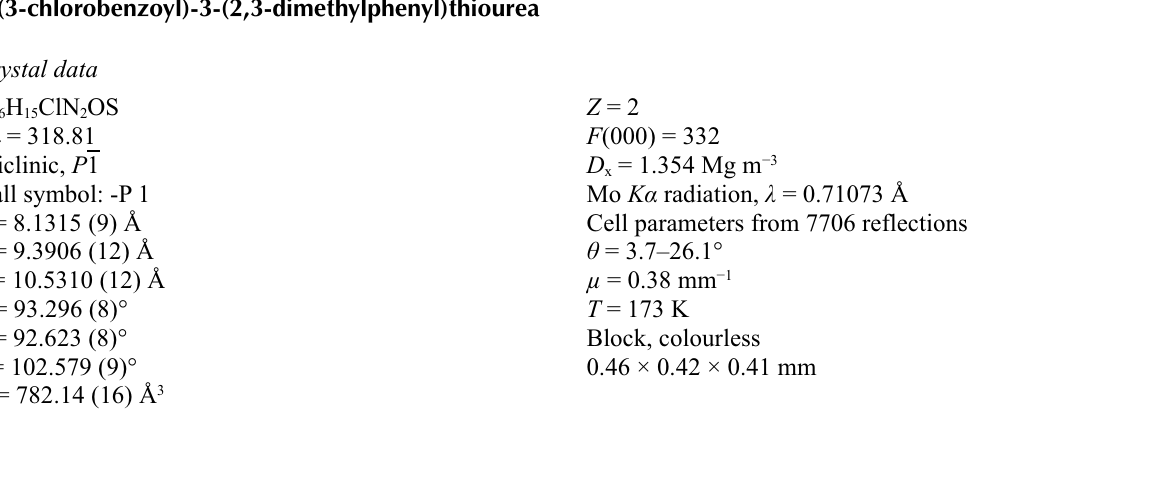
Packing diagram. Hydrogen bonds are shown as dashed